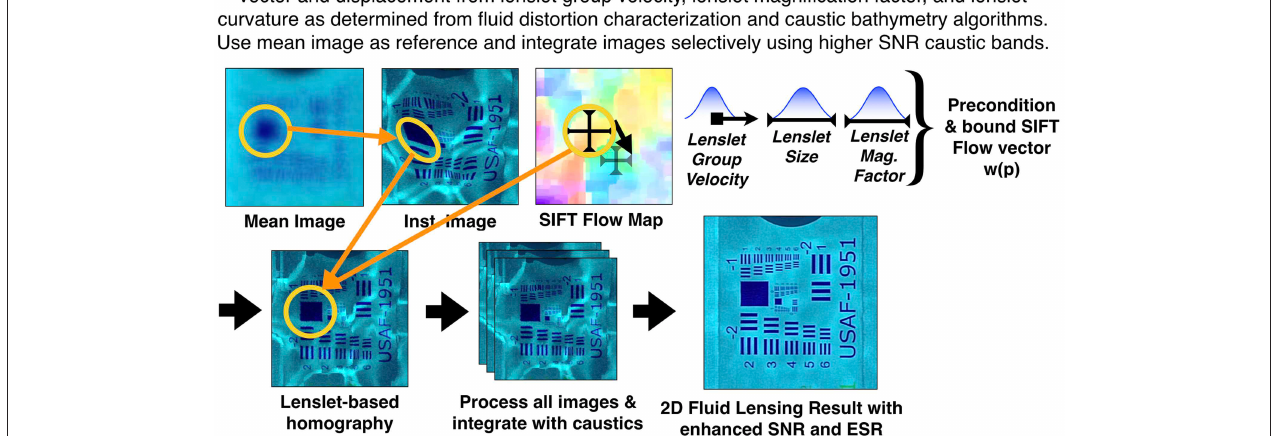
FIGURE 4 | An overview of the 2D Fluid Lensing Algorithm. Adapted with permission from Chirayath